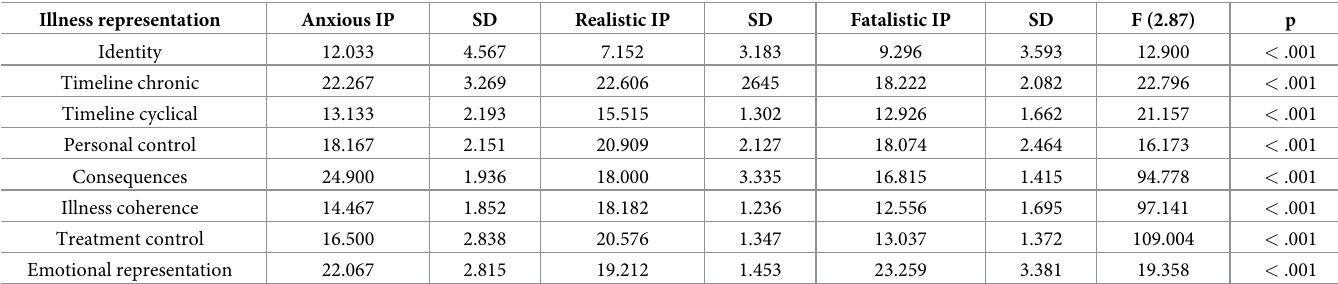
Table 5. Mean values of illness perception components in the individual